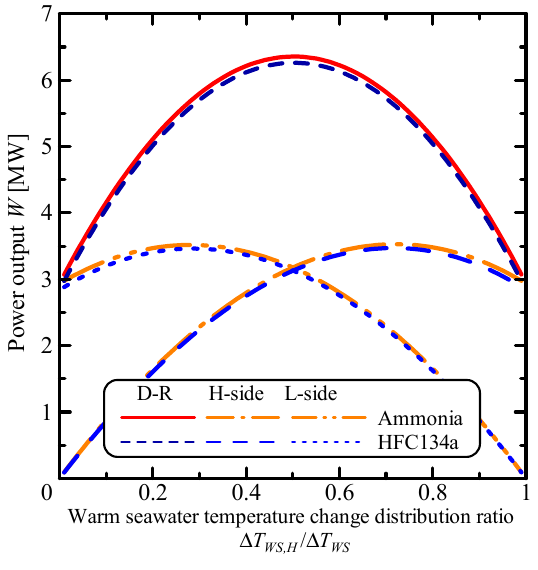
Figure 16. Relationship between the power output and the warm seawater temperature change distribution ratio.